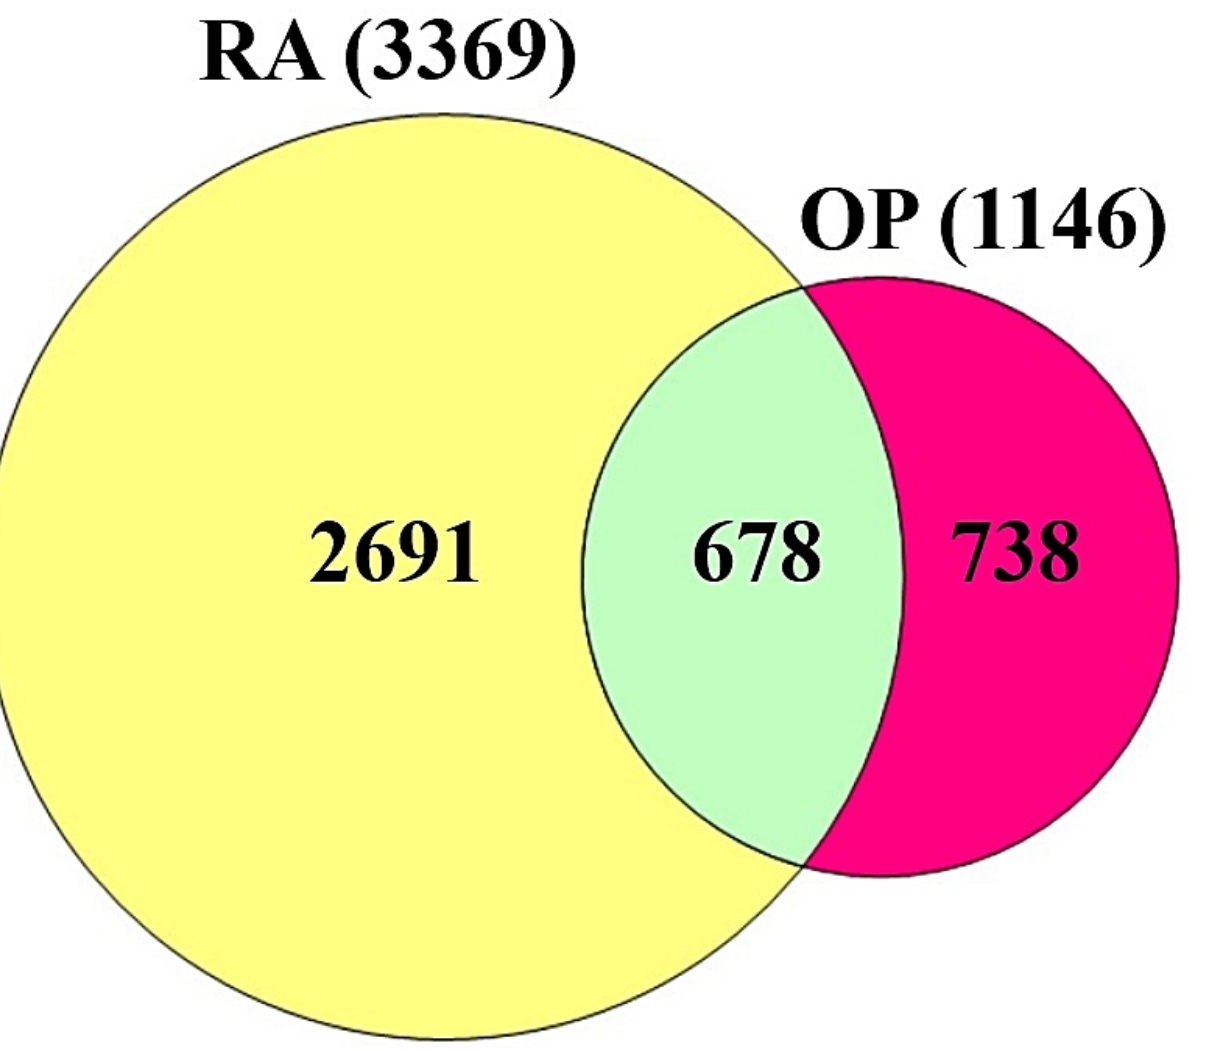
Figure 2. The overlapping targets between RA (3369 targets) and OP (1416 targets).